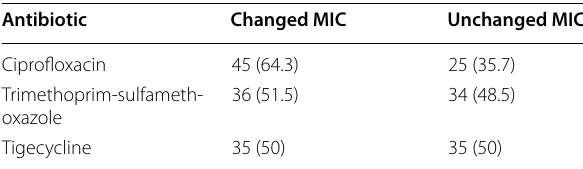
Table 2 Antibiotic resistance pattern before using CCCP pump inhibitor Antibiotic Resistance Semi sensitive Sensitive